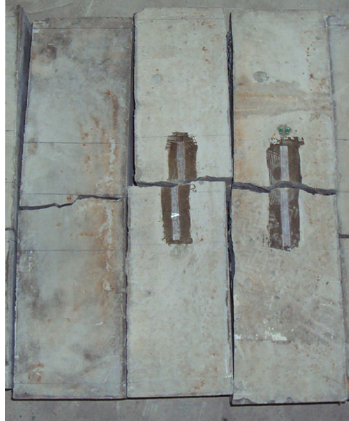
Figure 4: Failure mode of concrete specimens after flexural tests.